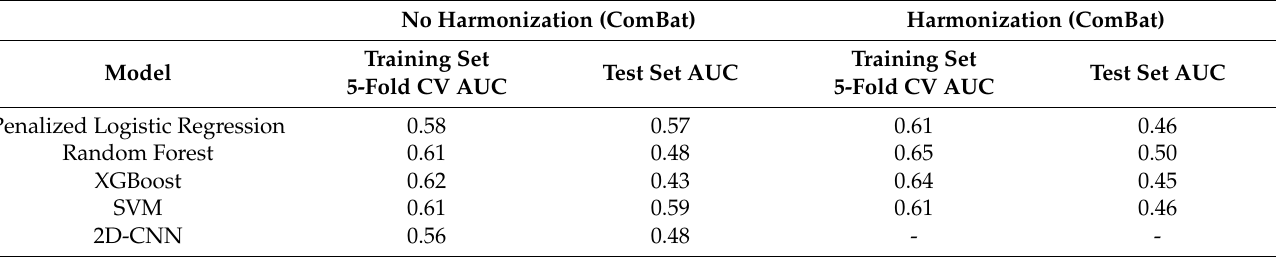
Table 4. Results of the models developed for the BRCA classification. Mean AUC of the 5-fold cross-validation (CV) obtained during model training and AUC of the test set for the analysis without or with ComBat harmonization are reported.